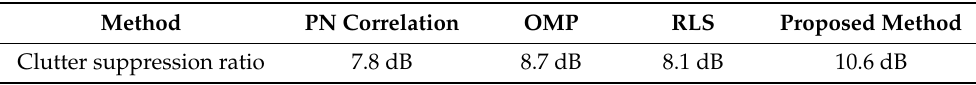
Figure 15. Clutter suppression result comparison of reference signal before and the after purification. Table 3. Clutter suppression ratio of different purification